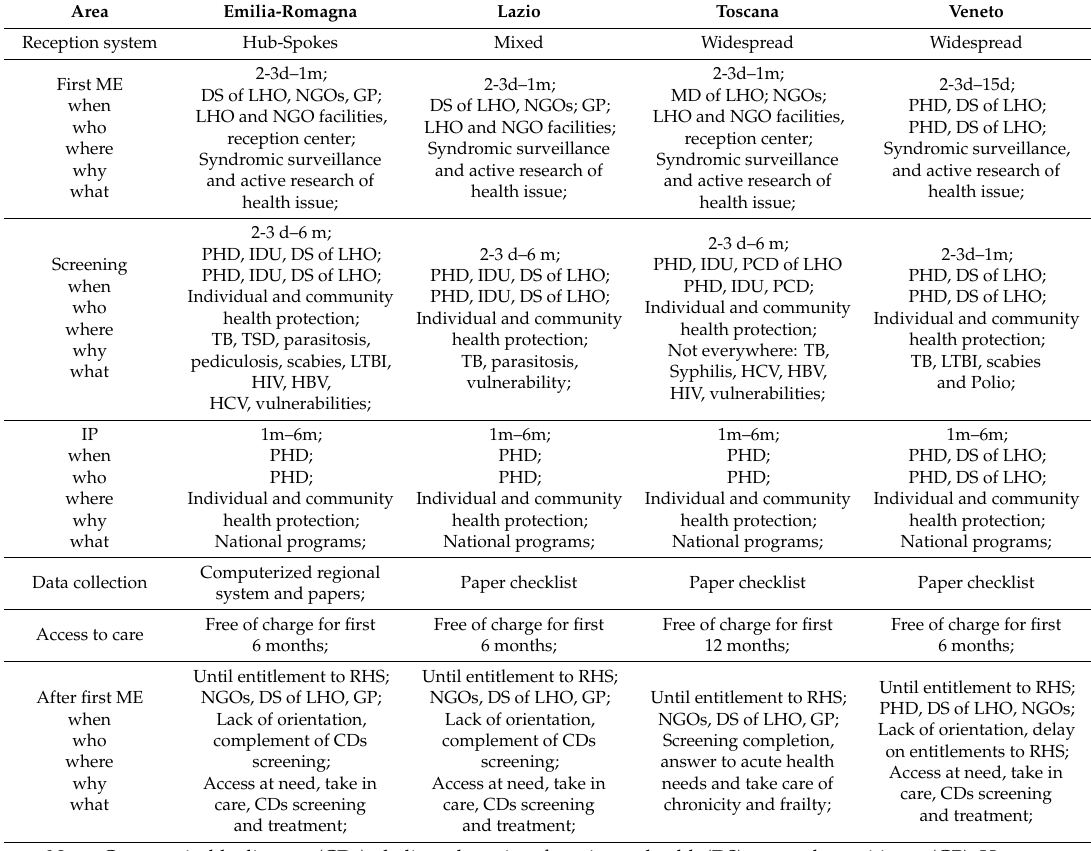
Table 3. Summary of Checklists: Practices at the LHO